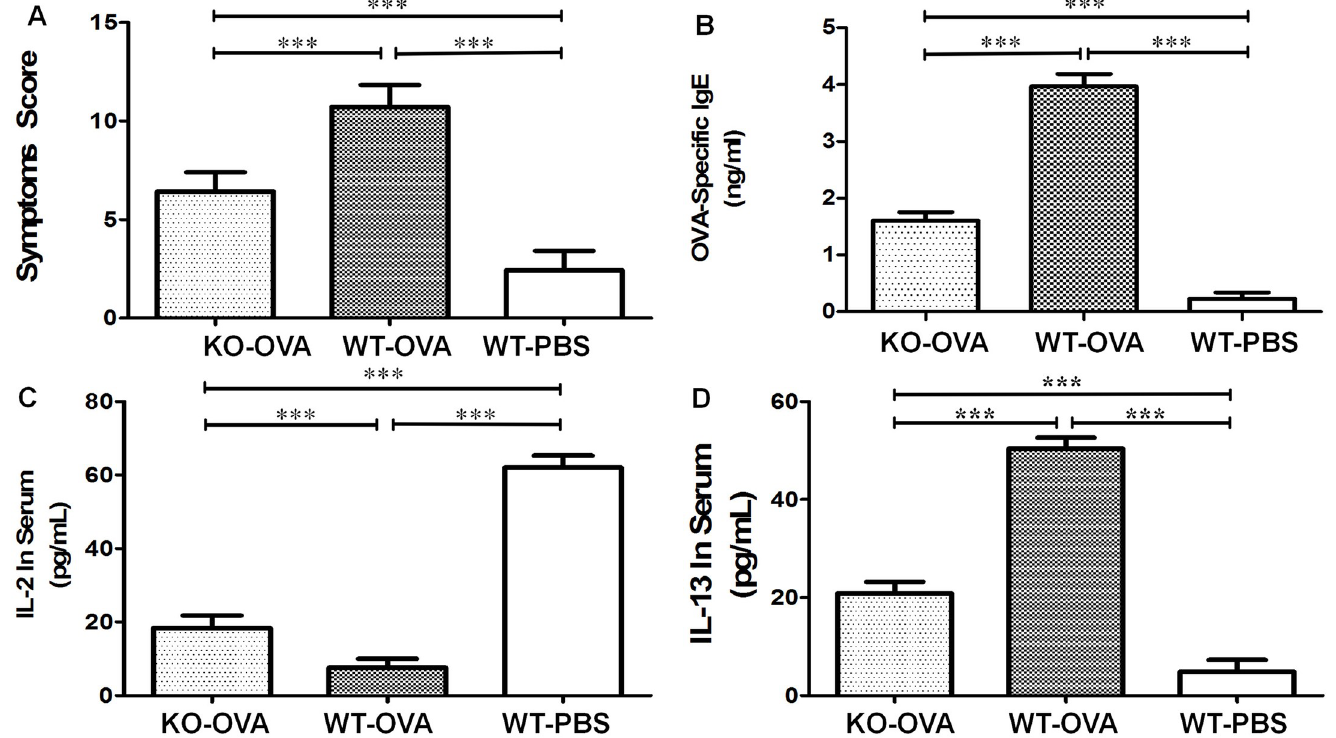
Fig 4. The results of the behavioral observation and scoring, and the concentrations of OVA-specific IgE, IL-2 and IL-13 in serum from the different groups. Panel A shows the behavioral observation scores for the mice in the three different groups. Panel B shows the concentrations of OVA-specific IgE in the serum of mice from different groups. Panel C shows the concentrations of IL-2 in the serum of mice from the different groups. Panel D shows the serum concentrations of IL-13 in the mice from different groups ( ��� P < 0.001, �� P < 0.01, � P < 0.05).